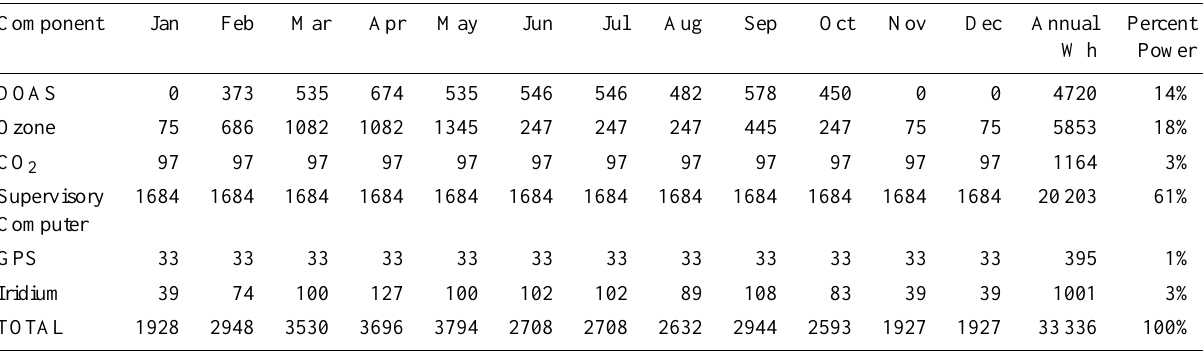
Table 1. Monthly energy consumption (Wh) for each instrument/component of the O-buoy. Each monthly value accounts for each instru- ment’s power draw and duty cycle in normal deployment